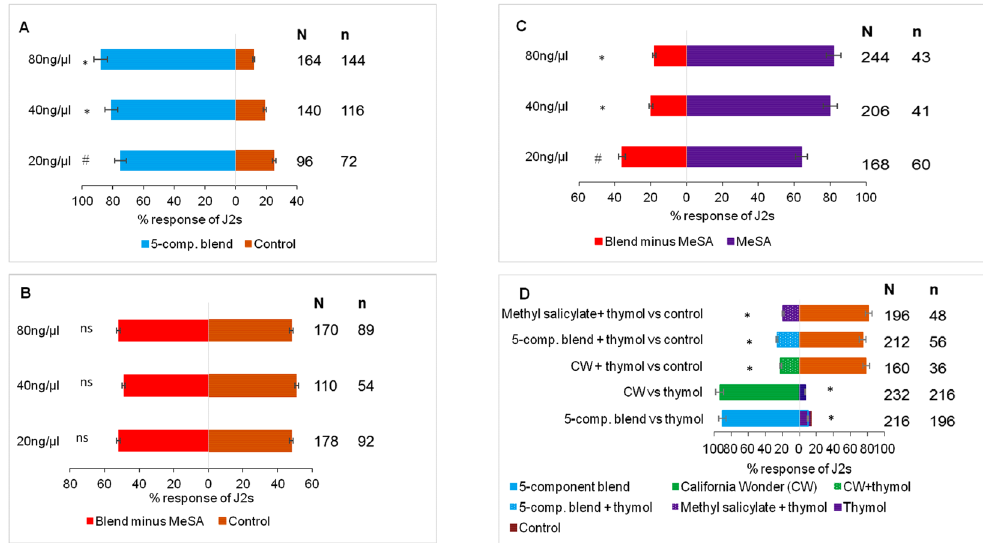
Figure 3. Differential responses of Meloidogyne incognita to synthetic blends and effect of thymol on their chemotaxis responses. Response of Meloidogyne incognita infective juveniles (J2s) to different doses of ( A ) 5-component blend compared to a control (moist sand). ( B ) Blend minus methyl salicylate (MeSA) compared to a control and ( C ) blend minus MeSA versus MeSA. N corresponds to the total number of responding J2 while n is the number of J2 corresponding to a given treatment. ( D ) Effect of thymol on response of Meloidogyne incognita infective juveniles (J2s) to methyl salicylate, the 5-component blend and cultivar California Wonder (CW). N corresponds to the number of responding J2 while n is the number of J2 corresponding to a given treatment. The level of significance in indicated by * P < 0.0001, # P < 0.05 and ns = not significant at P =